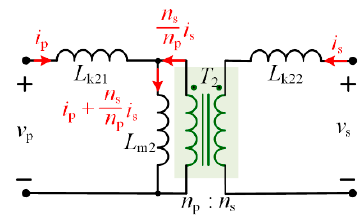
( b ) Figure 3. Equivalent winding connection way and EI (E-type and I-type) core structure of T 2 ( a ) equivalent connection way of T 2 , ( b ) EI core structure of T 2 .